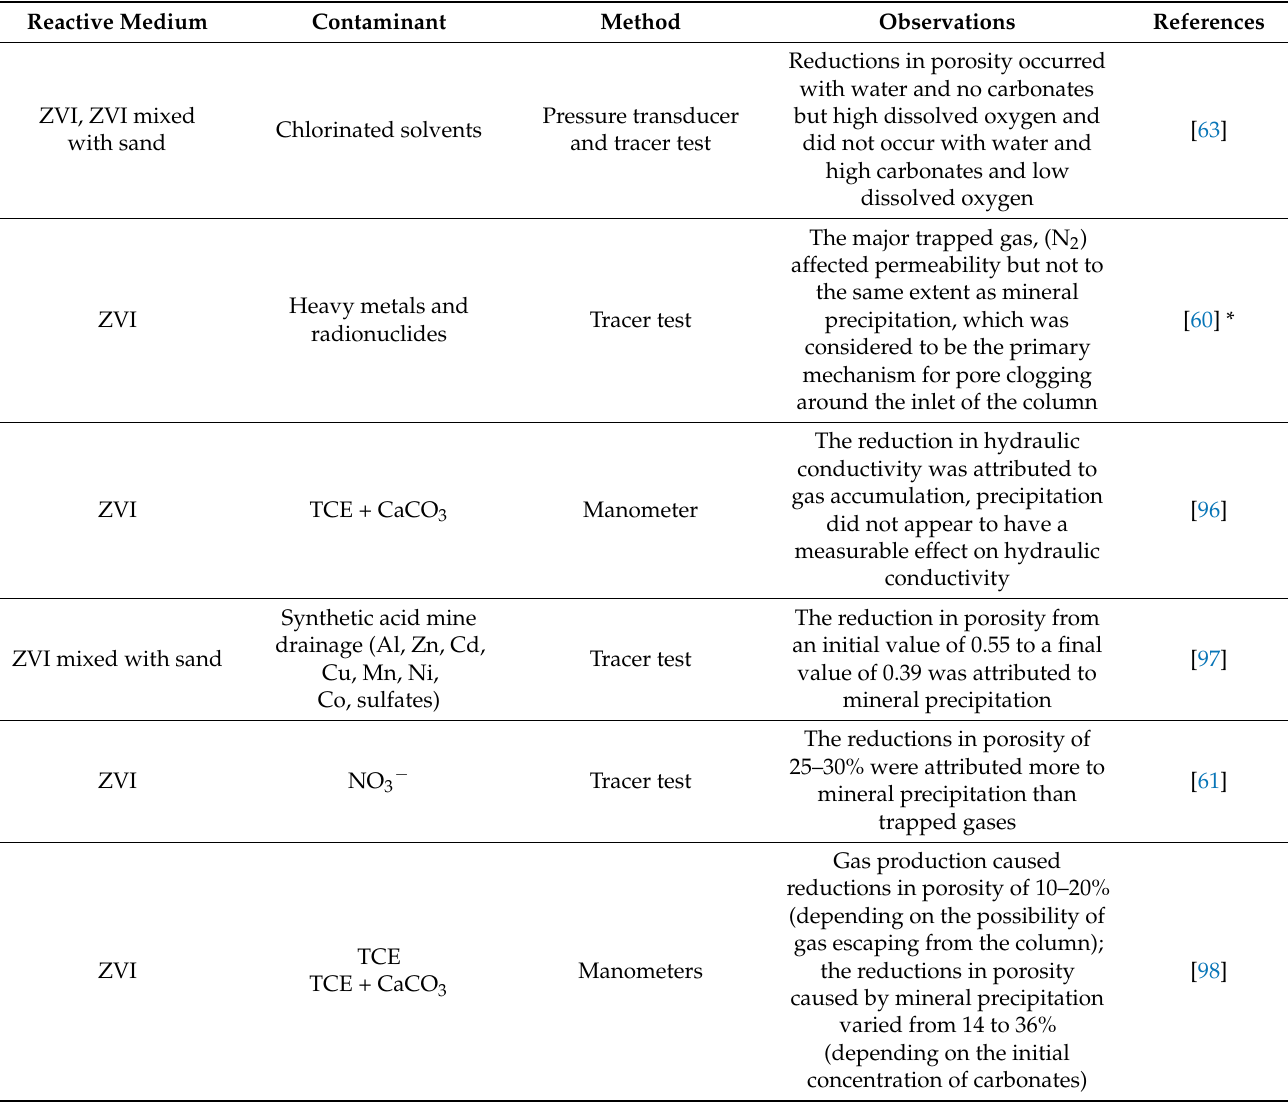
Table 3. Hydraulic behavior was investigated using column tests, which were carried out using reactive media composed of